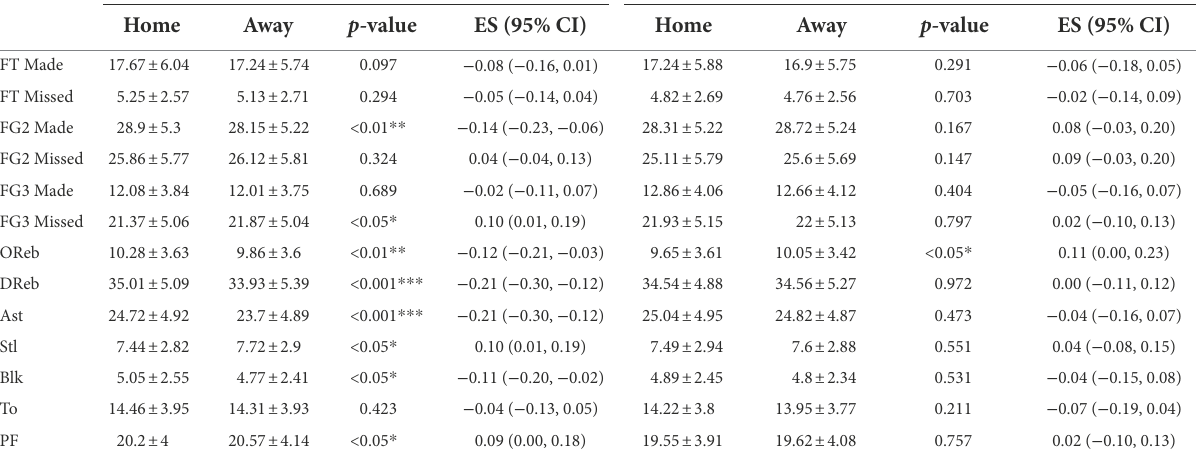
TABLE 1 Descriptive statistics of match performances before and after COVID-19 in the NBA. Before COVID-19 (with spectators) After COVID-19 (without